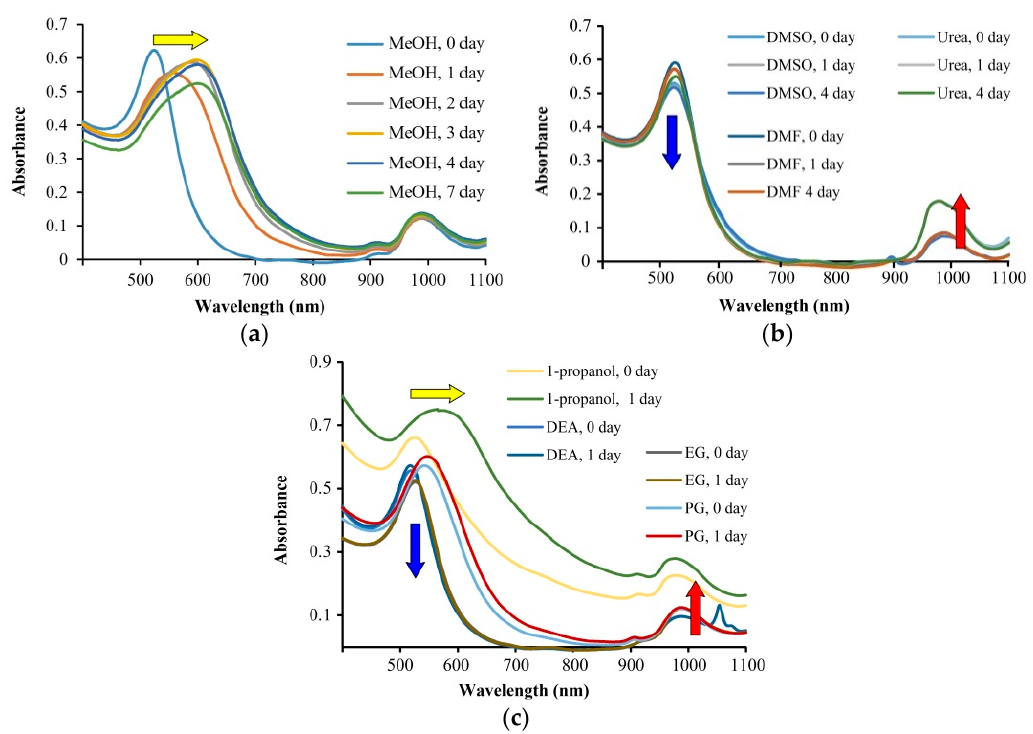
Figure 4. Spectral changes of nanogold solutions in 1–7 days after dissolution in different organic solvents. Depending on the nature of the solvent, spectral line intensity may be decreased (blue arrow) and increased (red arrow) or shifted to higher wavenumbers (yellow arrow). The spectral change corresponds to different types of aggregation: ( a ) the diameter of the spherical nanoparticles is increasing and the shape is preserved; ( b ) aggregation is occurring mainly in one dimension, resulting in the formation of rod-shaped particles; ( c ) the change of diameter and shape takes place simultaneously.